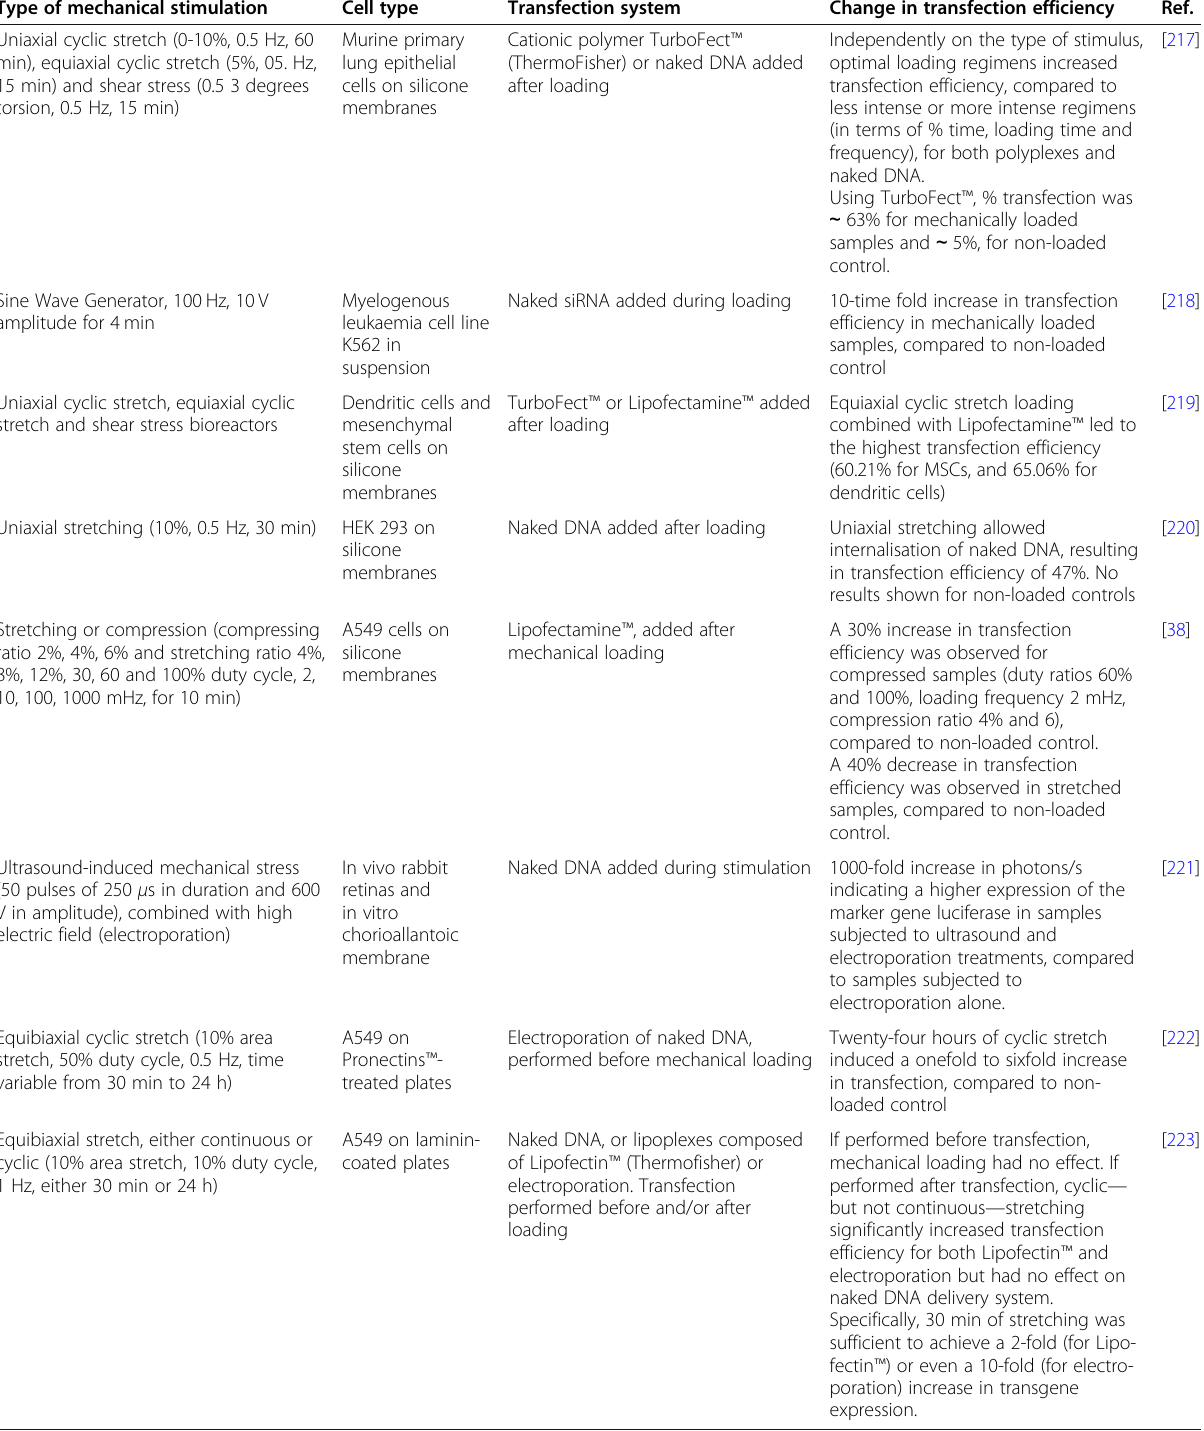
Table 5 Mechanical stimulation and gene delivery. Research papers assessing the effect of different mechanical loading regimens on non-viral-mediated gene